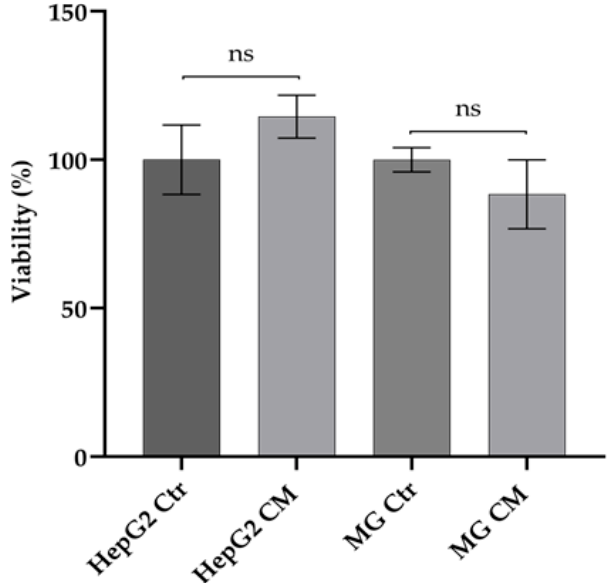
Figure 1. Effect of conditioned media on cell viability. Data represent the percentage cell viability of HepG2 and HMC-III cells grown for 48 h in conditioned (HepG2 CM and MG CM, respectively) and own-culture medium (HepG2 Ctr and MG Ctr, respectively). Standard error mean (SEM) was calculated using three replicates of three independent experiments. Statistical significance was assessed by using t -test. ns: not significant p -value.